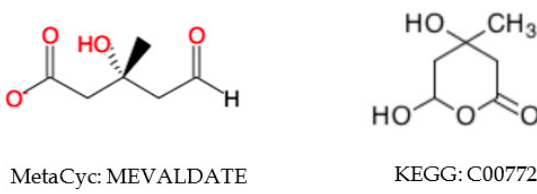
Figure 9. Compound with linear and circular representations.